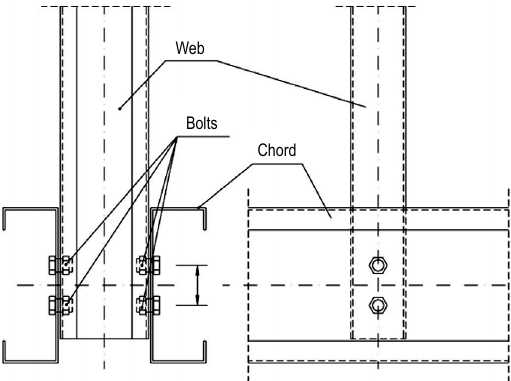
Fig. 5. Cold formed steel truss bolted